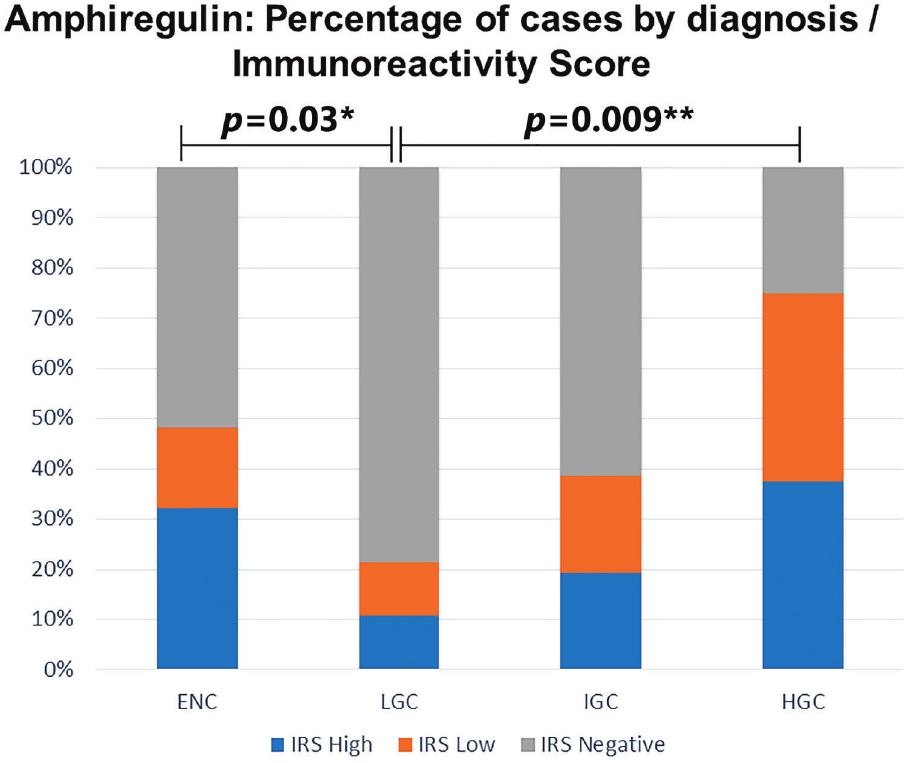
Figure 2 - Amphiregulin immunoreactivity score in enchondromas and chondrosarcomas. IRS, immunoreactivity score; ENC, enchondroma; LGC, low-grade chondrosarcoma; IGC, intermediate-grade chondrosarcoma; HGC, high-grade chondrosarcoma. (*) Chi-squared test; (**) Fisher ’ s Exact